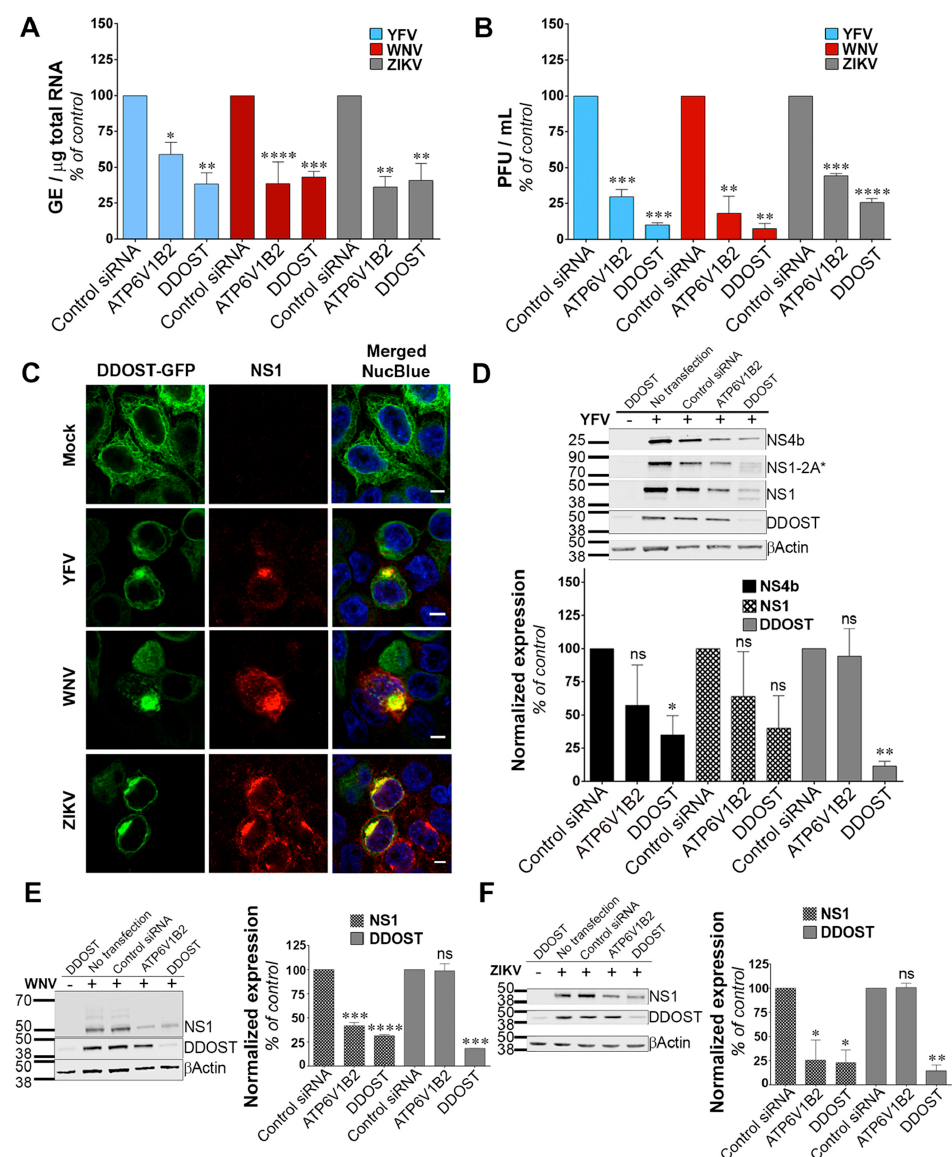
Figure 3. Dolichyl-diphosphooligosaccharide—protein glycosyltransferase non-catalytic subunit (DDOST) is a flavivirus host factor. ( A ) Forty-eight hours after transfection with siRNA, HeLa cells were infected with YFV, WNV or ZIKV at an MOI of 1. The relative amounts of cell-associated viral RNA were determined by qPCR analysis at 24 h post-infection. Amounts of viral RNA are expressed as genome equivalents (GE) per µ g of total cellular RNA and normalized to the sample transfected with non-targeting control siRNA. ( B ) The presence of infectious virus released in the culture medium of infected HeLa cells was measured by plaque assays. Results are expressed as plaque forming units (PFU) per mL and normalized to the sample transfected with non-targeting control siRNA. ( C ) HeLa cells transiently expressing GFP-tagged DDOST were infected with YFV, WNV or ZIKV. Cells were stained with anti-NS1 (red) and NucBlue (blue) 24 h post-infection. Ten microscopic fields were analyzed Scale bars are 5 µ m. ( D – F ) HeLa cells were infected with YFV ( D ), WNV ( E ), or ZIKV ( F ) 48 h after transfection with siRNA. The level of viral protein was determined by SDS-PAGE and Western blotting 24 h post-infection. The band signal is normalized to the loading control ( β Actin) and is expressed as percent of protein expression in the sample transfected with non-targeting control siRNA. Data in ( A , B , D – F ) are represented as mean ± SD of two independent experiments. Significance was calculated using a one-way ANOVA or unpaired t tests of comparisons to control siRNA-transfected